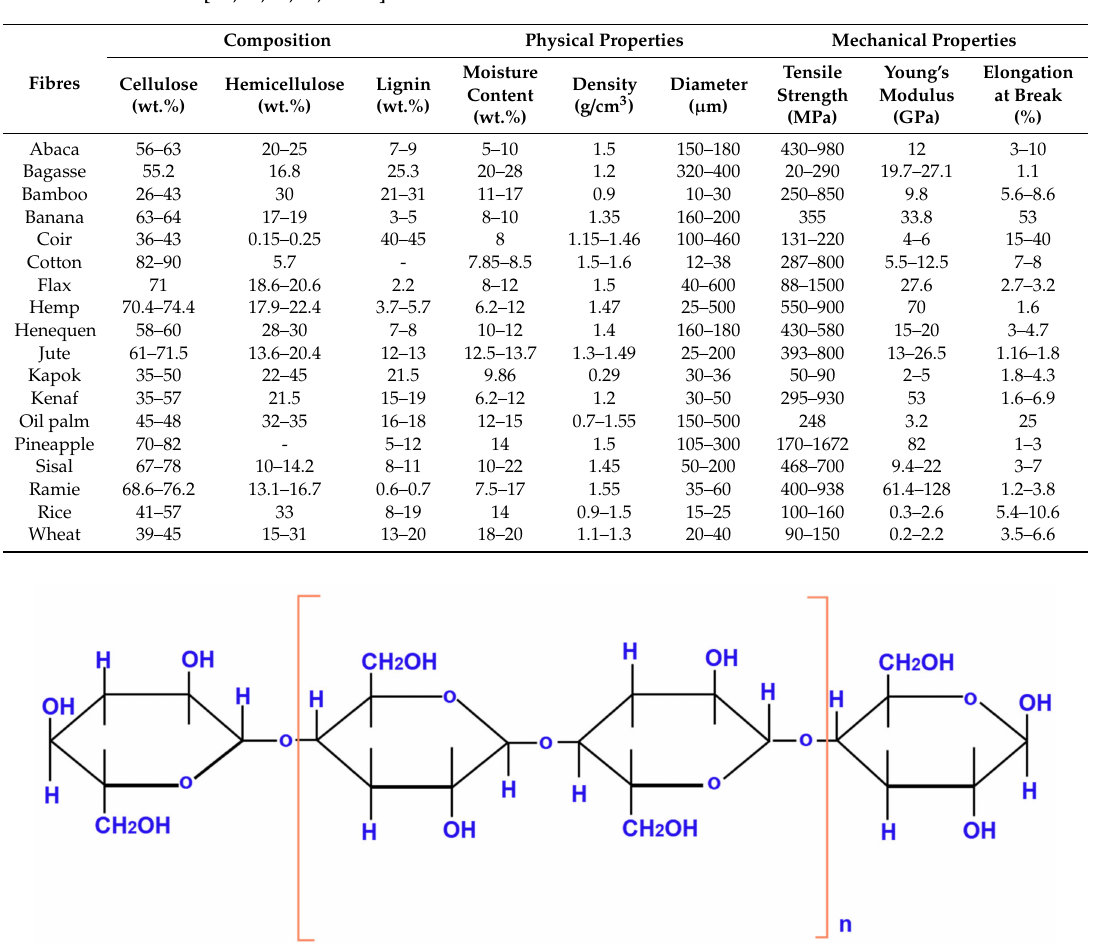
Table 1. Chemical constituents and physical and mechanical properties of the plant-based natural cellulosic fibres [10,21,25,52,54–60].